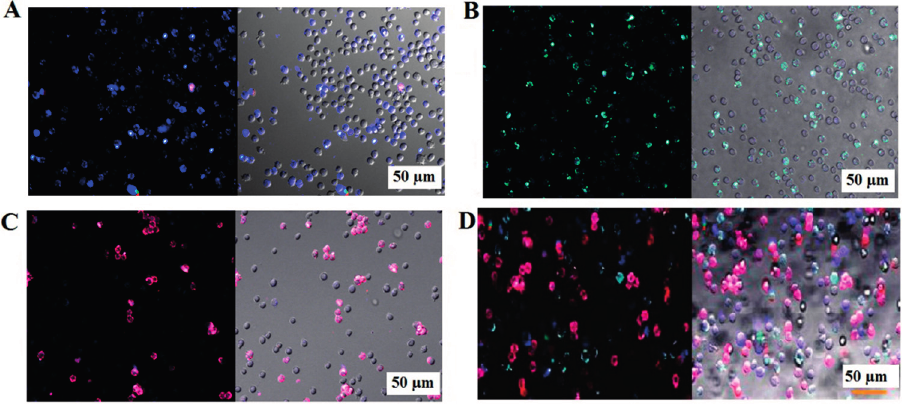
Figure 5. Confocal microscopic images showing a mixture of three cells (Toledo, CEM, and Ramos) incubated with ( A ) FAM-T1-SiNP; ( B ) FAM-R6G-sgc8-SiNP; and ( C ) FAM-R6G-ROX-TD05-SiNP (specific for Toledo, CEM and Ramos cells, respectively); ( D ) Mixture of the three cells incubated with all three different Apt-dye-SiNPs. The aptamers T1, sgc8 and TD05 are known to specifically bind with Toledo, CEM and Ramos cells, respectively. The image was adopted from